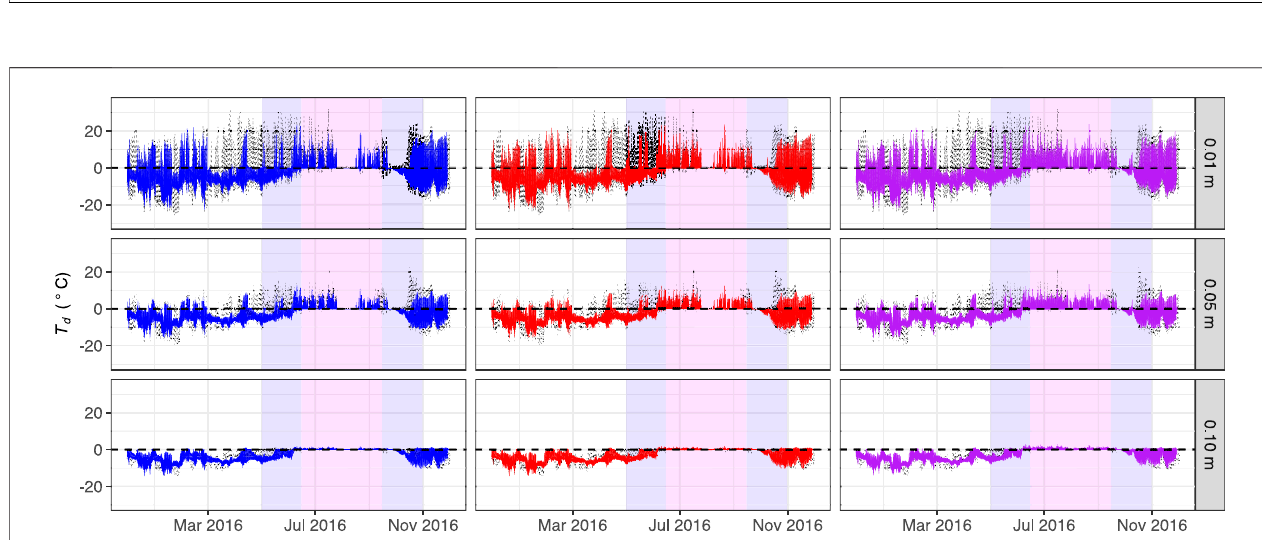
FIGURE9| Observeddebristemperature, T d ,atdepths d =0.01,0.05and0.10 minPit1(stippedblackline).MonteCarlosimulationsofthesame( n =2,000)have been grouped to second order, with the colour blue used for branch 2a, red for branch 2b and purple for branch 1b.